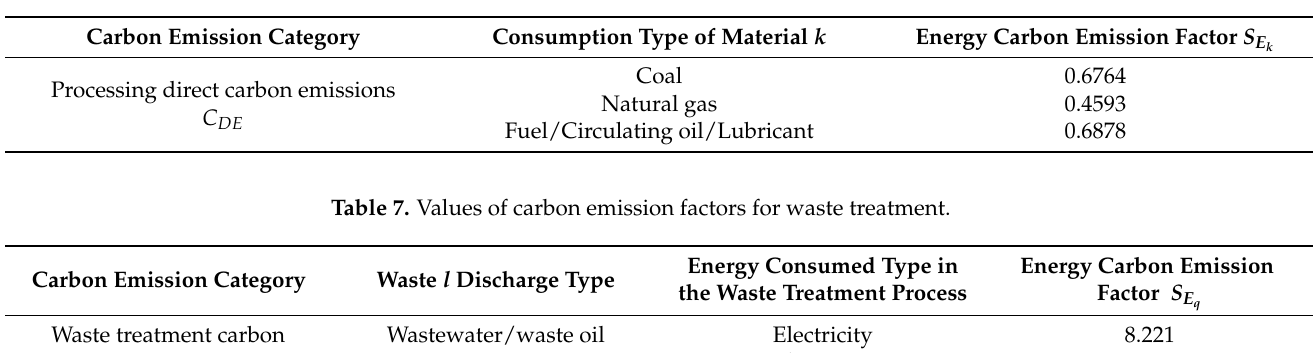
Table 6. Values of direct carbon emission factors from fossil energy consumption.